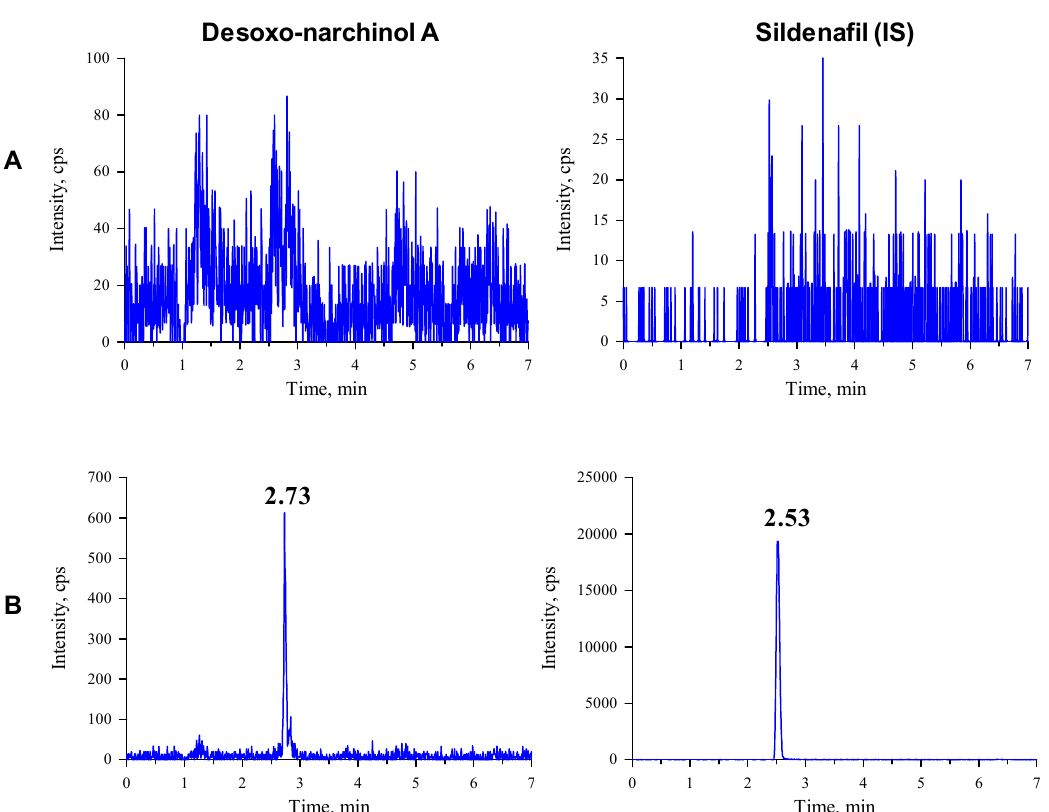
Figure 2. Representative chromatograms of desoxo-narchinol A (left) and the internal standard (right) in the ( A ) blank mouse plasma and ( B ) blank mouse plasma spiked with desoxo-narchinol A (LLOQ) and IS.